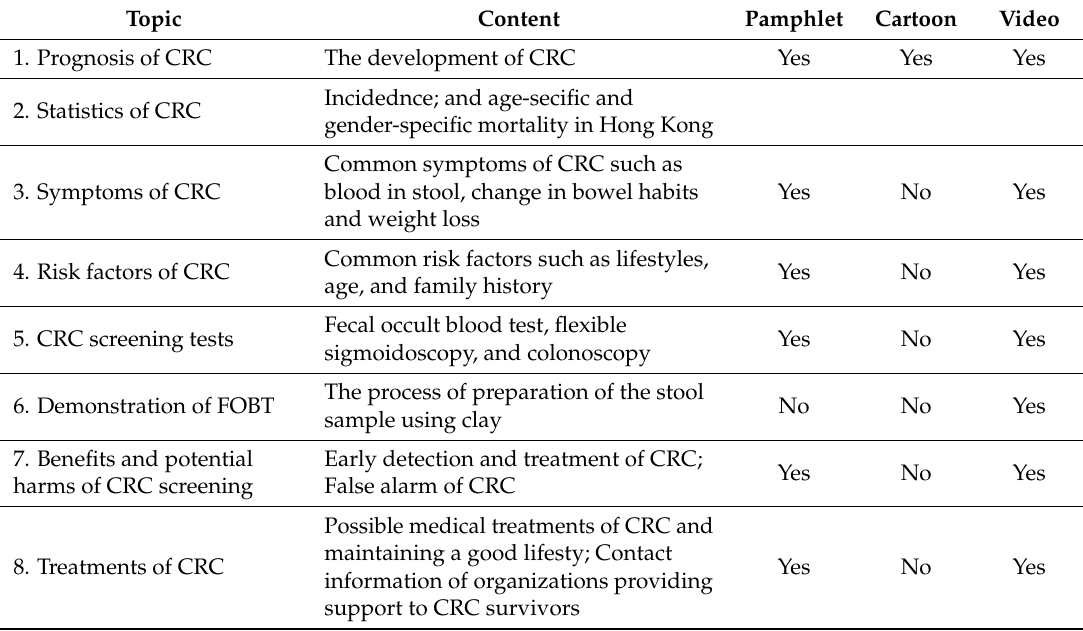
Table 1. Content of the three CRC promotional materials. Topic Content